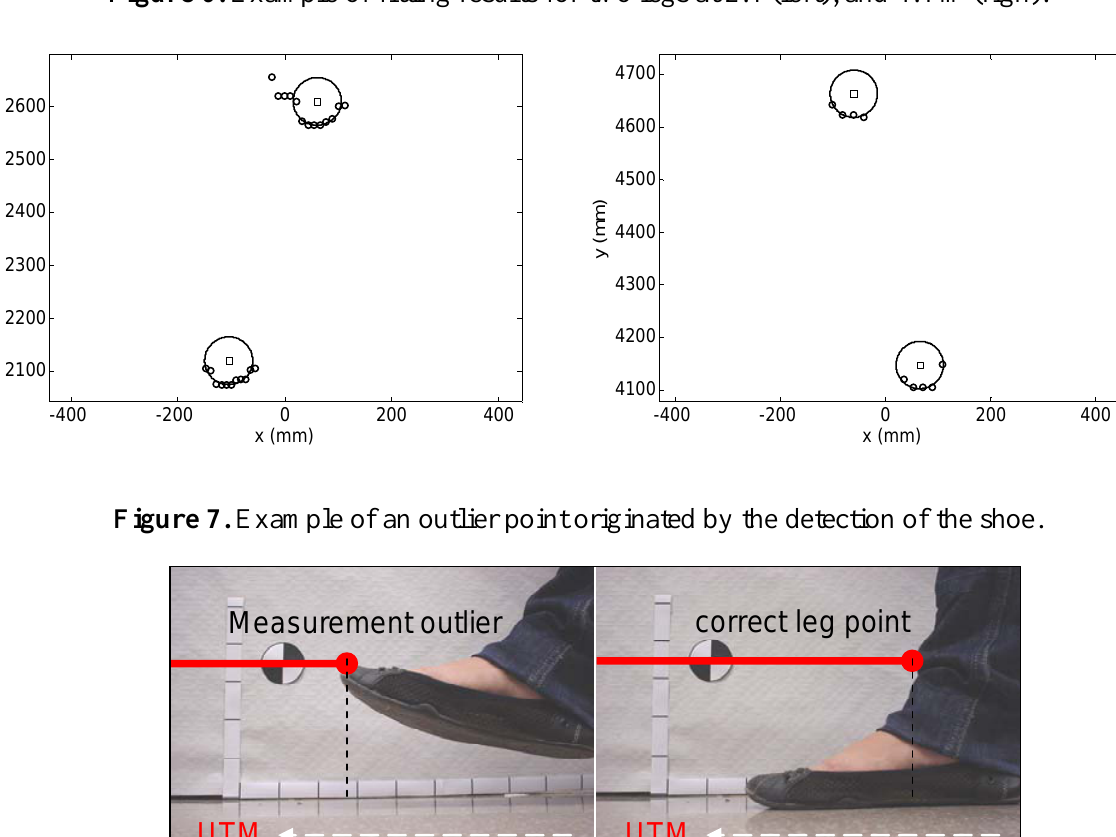
Figure 6. Example of fitting results for two legs at 2.4 (left), and 4.4 m (righ).